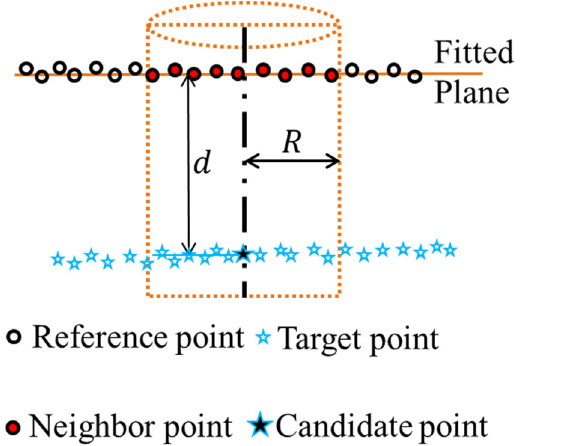
Figure 4. Definition of point to plane distance. For each target point, the neighbor points are those within the cylinder with a radius of (cid:1844) . A fitted plane is constructed by least squares estimation, and the distance of the candidate point to the fitted plane is defined as the point to plane